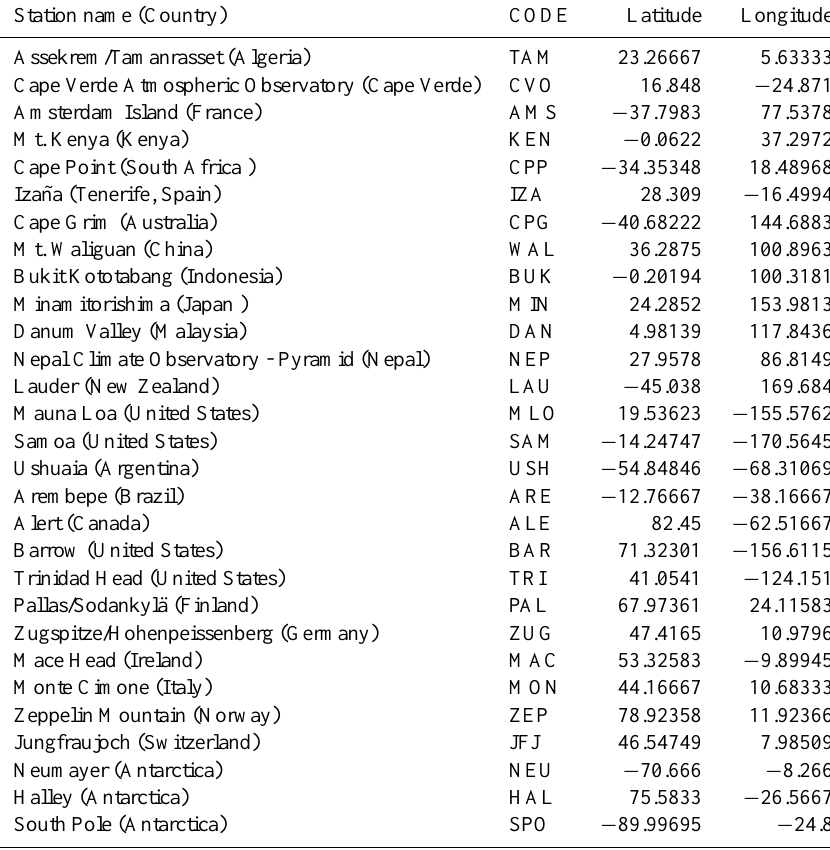
Table 3. List of the 28 GAW Global stations with three letter code names and locations. Station name